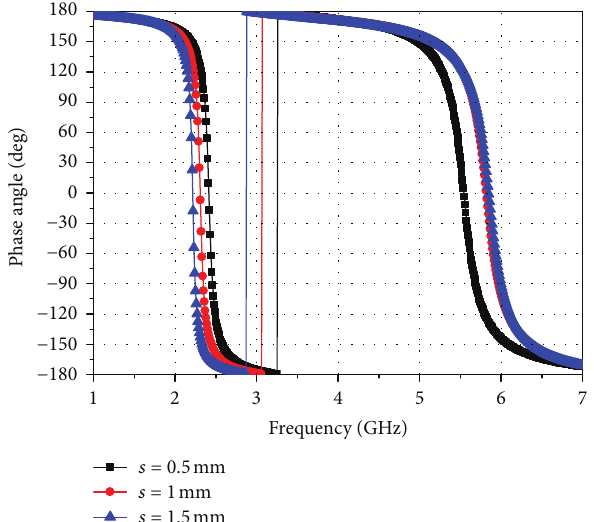
Figure 6: Effect of AMC parameter 𝑠 .